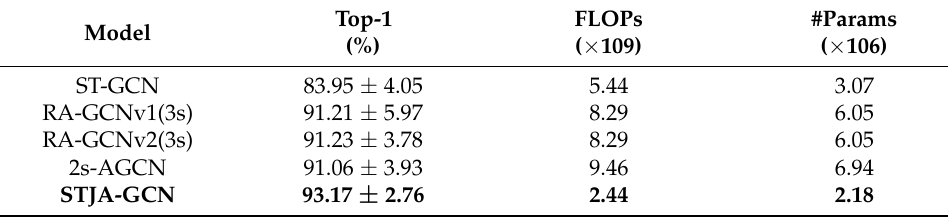
Table 4. Comparison of results on Kinect25.